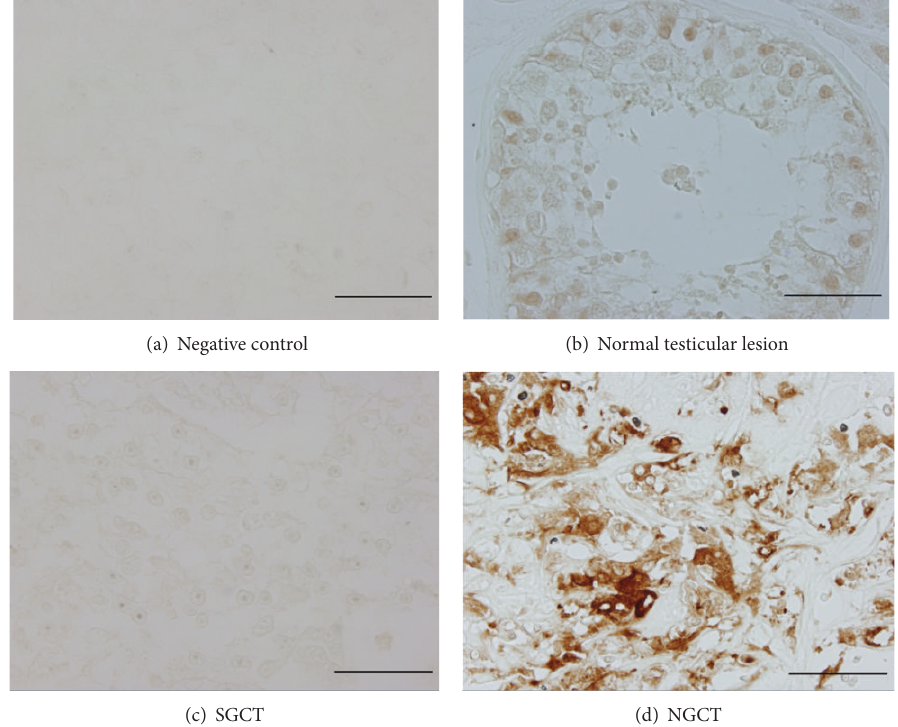
Figure 1: Immunohistochemistry of amyloid precursor protein (APP) in testicular tissue specimens. (a) Negative control showing negative immunostaining. (b) Normal testicular lesion showing weak staining (intensity score: 1). (c) Seminomatous germ cell tumor lesion showing negative immunostaining (intensity score: 0). (d) Nonseminomatous germ cell tumor lesion (embryonal cancer component) showing strong APP immunostaining (intensity score: 3). Scale bars , 50 𝜇 m.